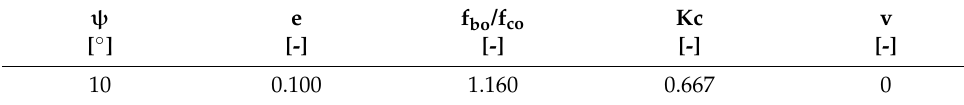
Table 9. Concrete Damage Plasticity parameters used in this work.